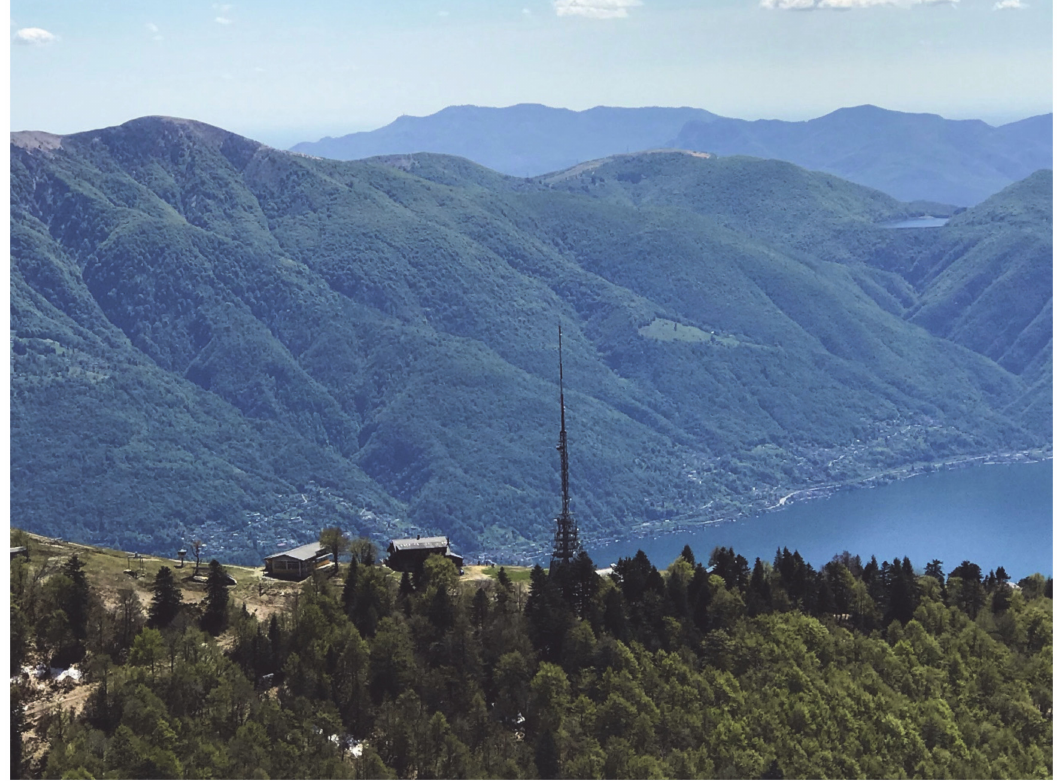
Figure 1. Looking south towards Monte Lema from a point an altitude of ~1800 m North of Cimetta; from left to right, the chairlift arrival, the hut and the 90 m tall metallic tower